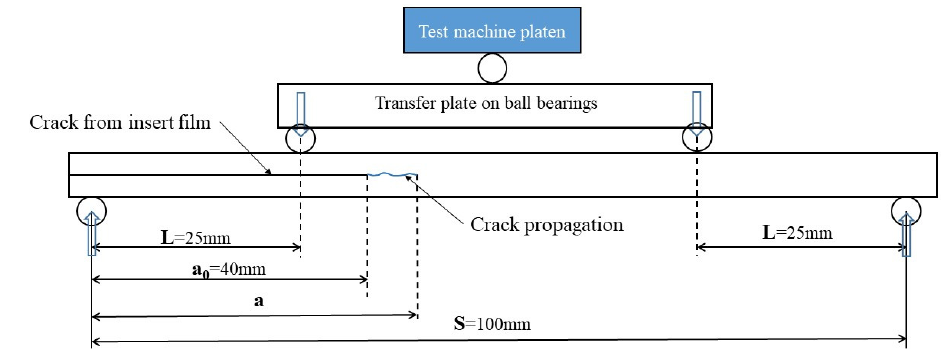
Figure 4. Mode II 4-ENF specimen configuration.